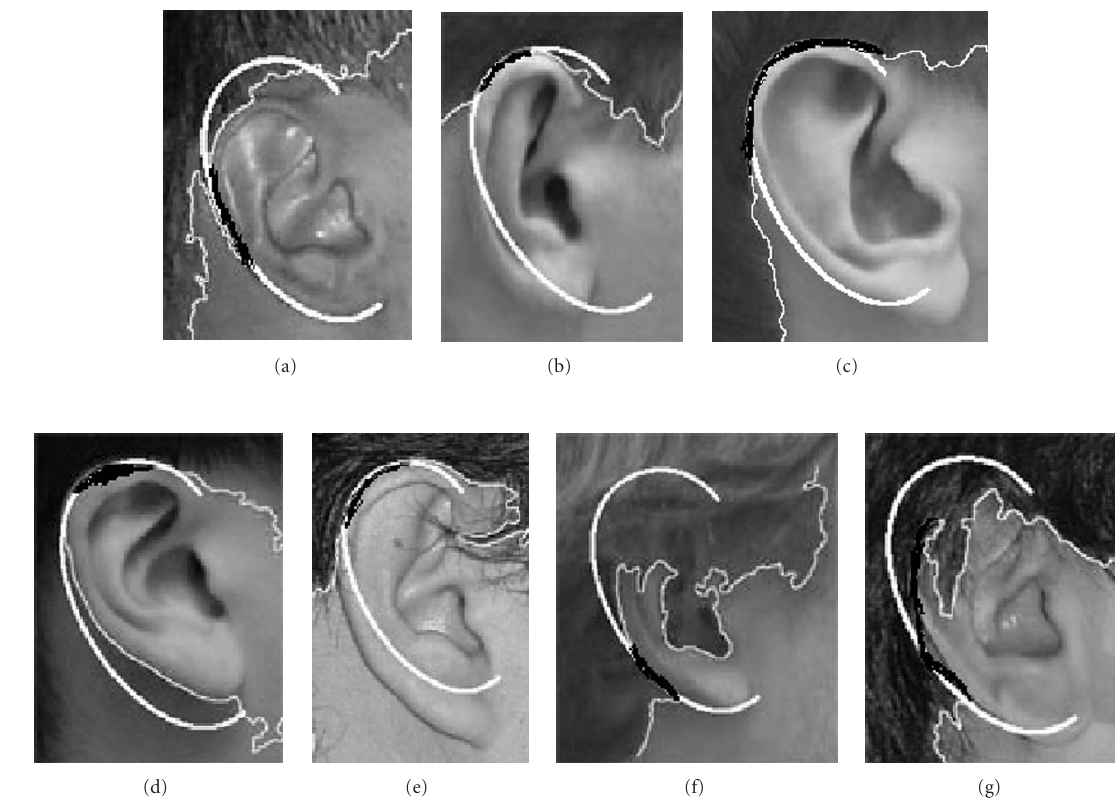
Figure 11: The results of ear initialization with skin-color boundary (thin grey curve), translated ear template (thick white curve), and the matched partial segments (thick black curve) on both skin-color boundary and the ear template.